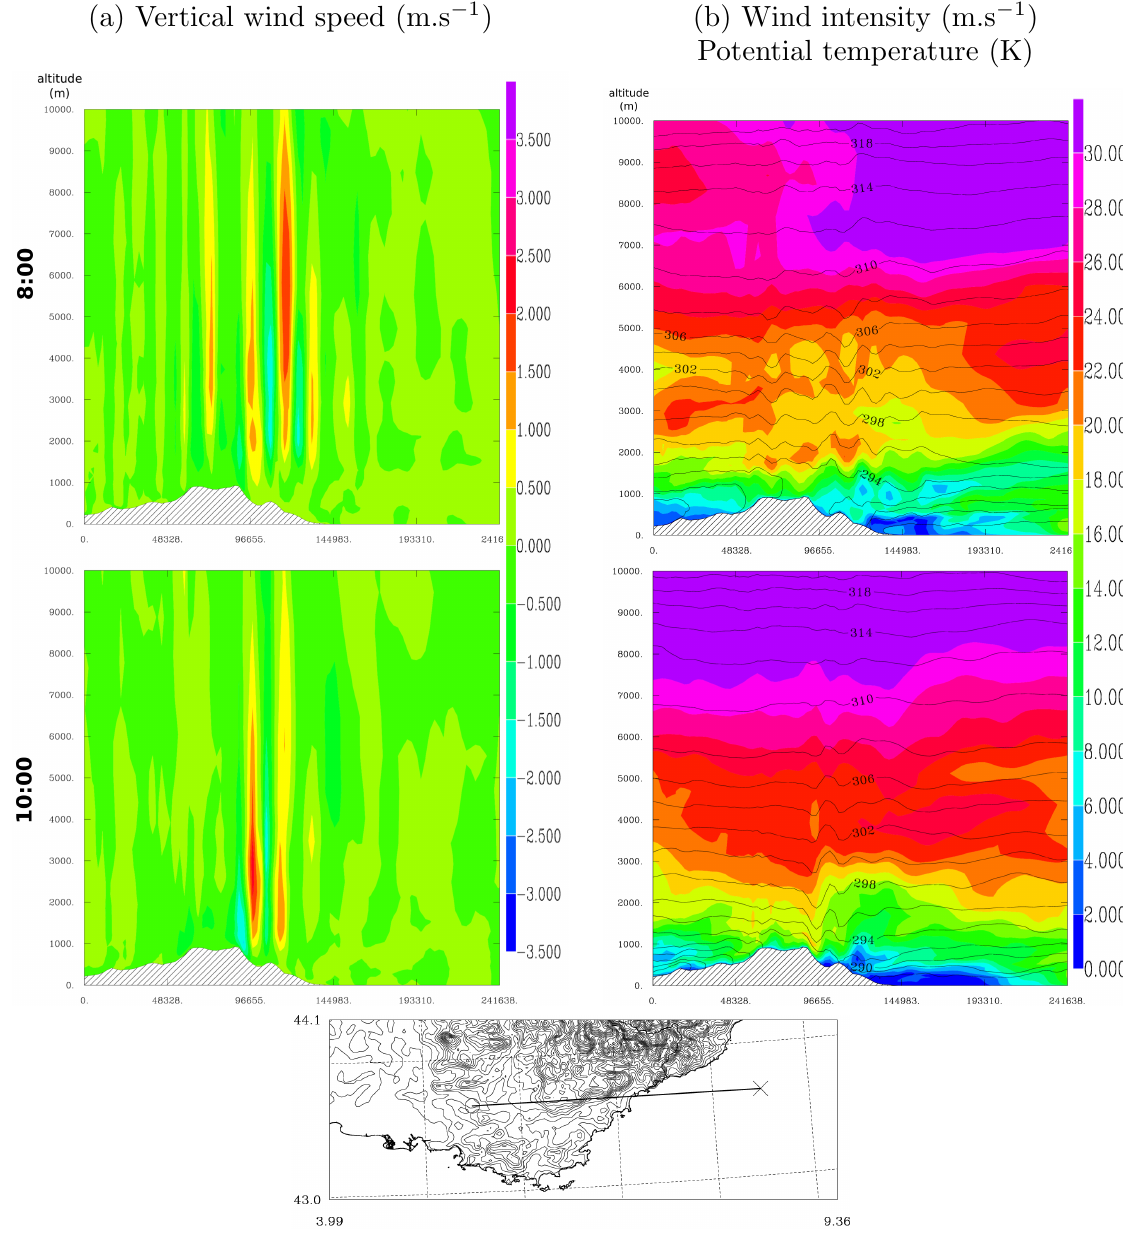
Fig. 17. Cross section of vertical wind speed (a) and potential temperature isolines superimposed on wind intensity (b) from ground to 10km high directed from west to east through Nice on 27 March 2009 at 08:00 (up) and 10:00UTC